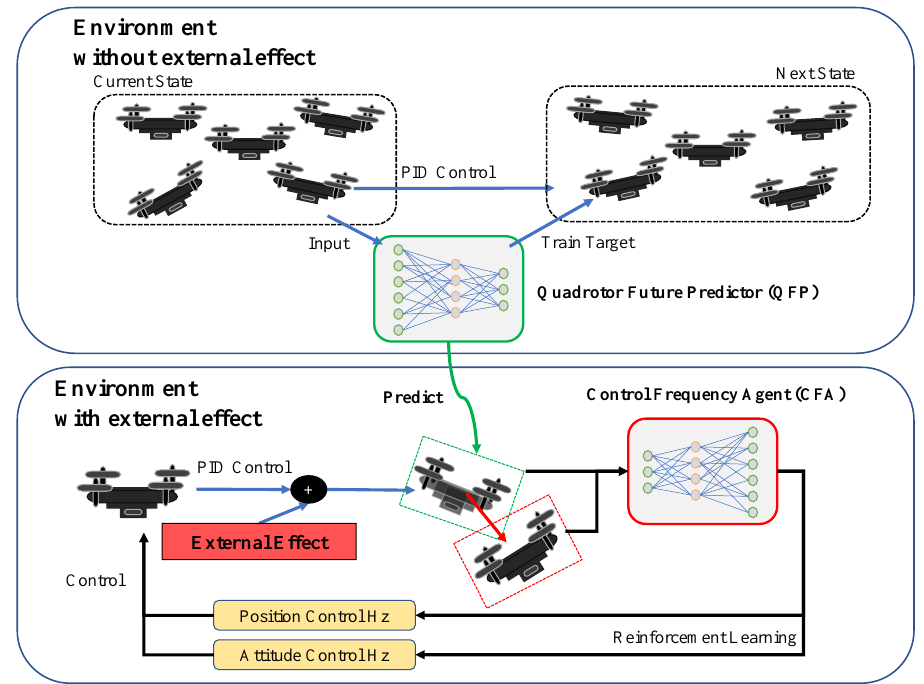
Figure 4. The proposed QFP and CFA models. QFP is trained to predict the next position of a quadrotor controlled by PID in the environment without external effects. After training, the next state estimated by QFP is used as the input of CFA. Then, CFA is trained to adjust the ratio of the position and attitude control frequencies against external effects by maximizing the given reward function. The approximated external effect is computed as the difference between the current state (in a red dashed box) and the estimated state (in a green dashed box). CFA is trained to balance the position and attitude control frequencies for time-optimal waypoint tracking